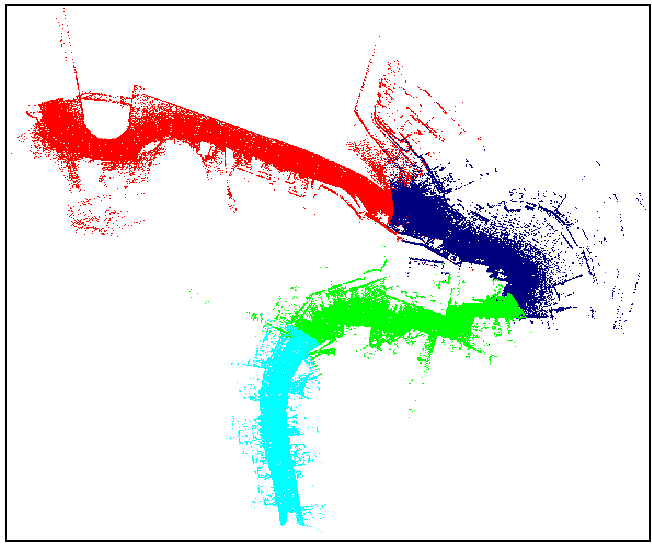
Figure 2. Original MLS point cloud in dataset 1 divided into four sections (represented by different colors).